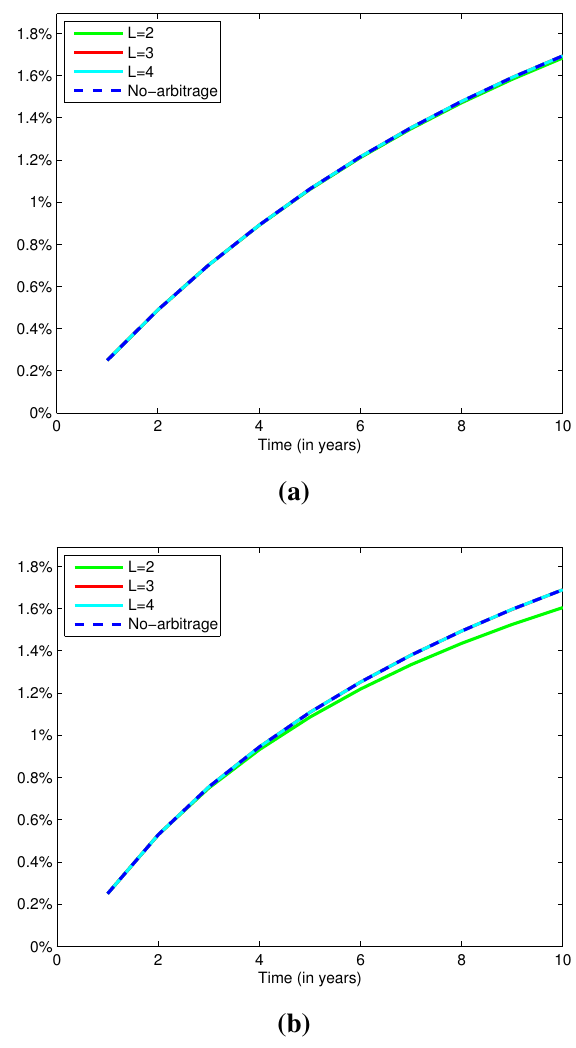
Figure 2. No-arbitrage and best-estimate projected yield curves. ( a ) Parameter set 1; ( b ) Parameter set 2.